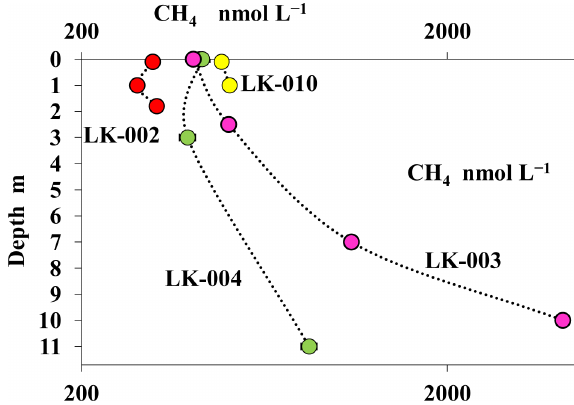
Figure 5. Concentrations of dissolved methane (CH 4 , nmolL − 1 ) in the water columns of four Yamal tundra lakes: LK-002 (red), LK- 010 (yellow), LK-003 (purple), and LK-004